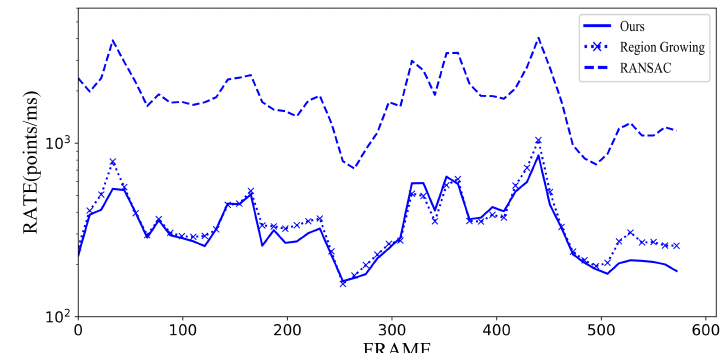
Figure 5. Runtime comparison of Hope and state-of-the-art on the freburg1_desk sequence. All runtime of three methods depends on the complexity of the scene. Despite that our approach involves extra result refining and identification procedures, our performance is compatible with original RG